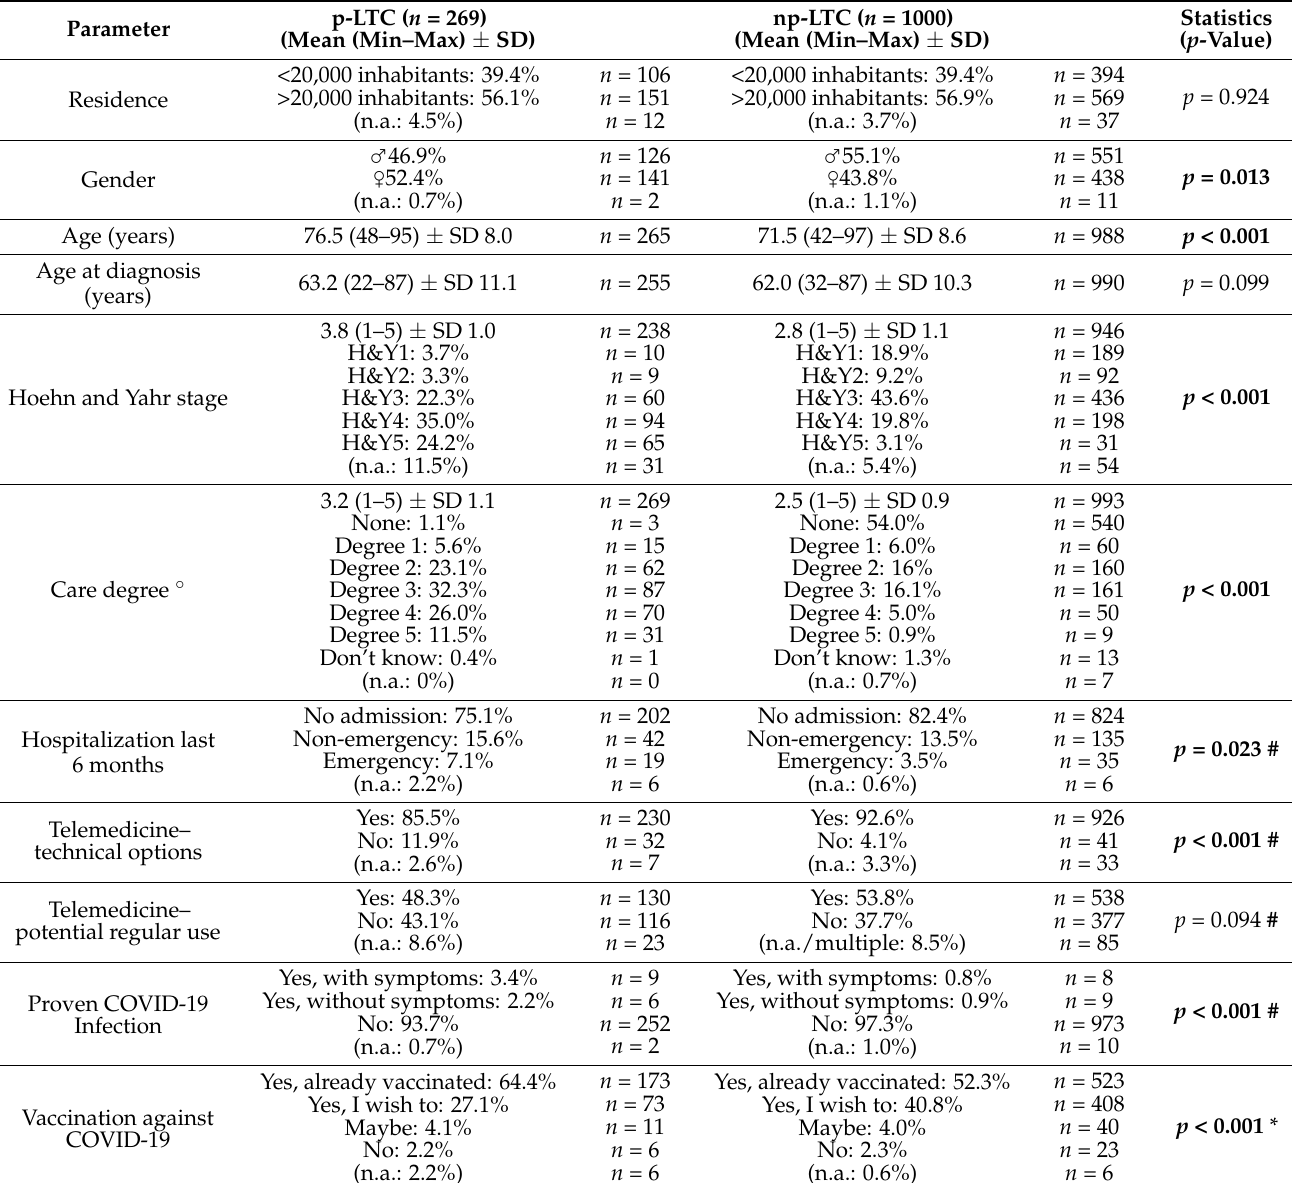
Table 1. Demographic and clinical data of people with Parkinson’s disease with (p-LTC) and without (np-LTC) professional long-term